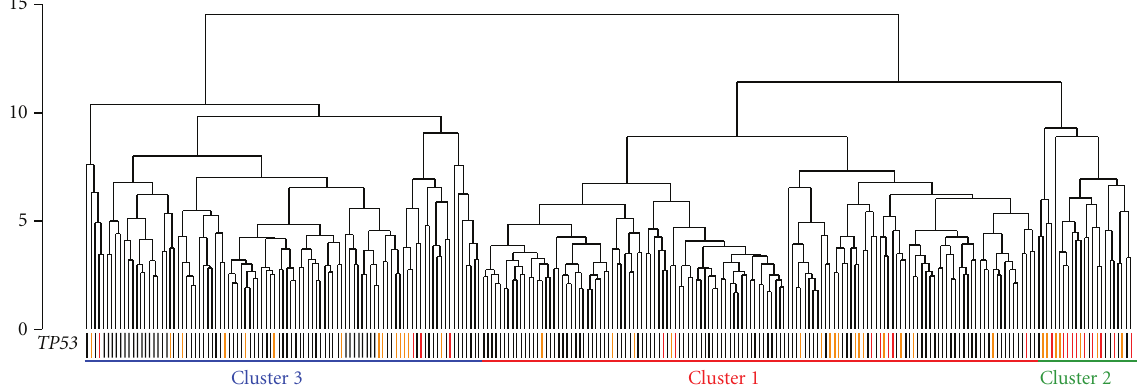
Figure 5: Tumor dendrogram from clustering 251 tumors and 30 genes associated with intrinsic breast cancer phenotypes (luminal, basal, ERBB2 , and claudins). Black bars denote tumors with a wild-type p53; orange bars, tumors with a mutant p53 (missense mutation); red bars, tumors with a mutant p53 (severe